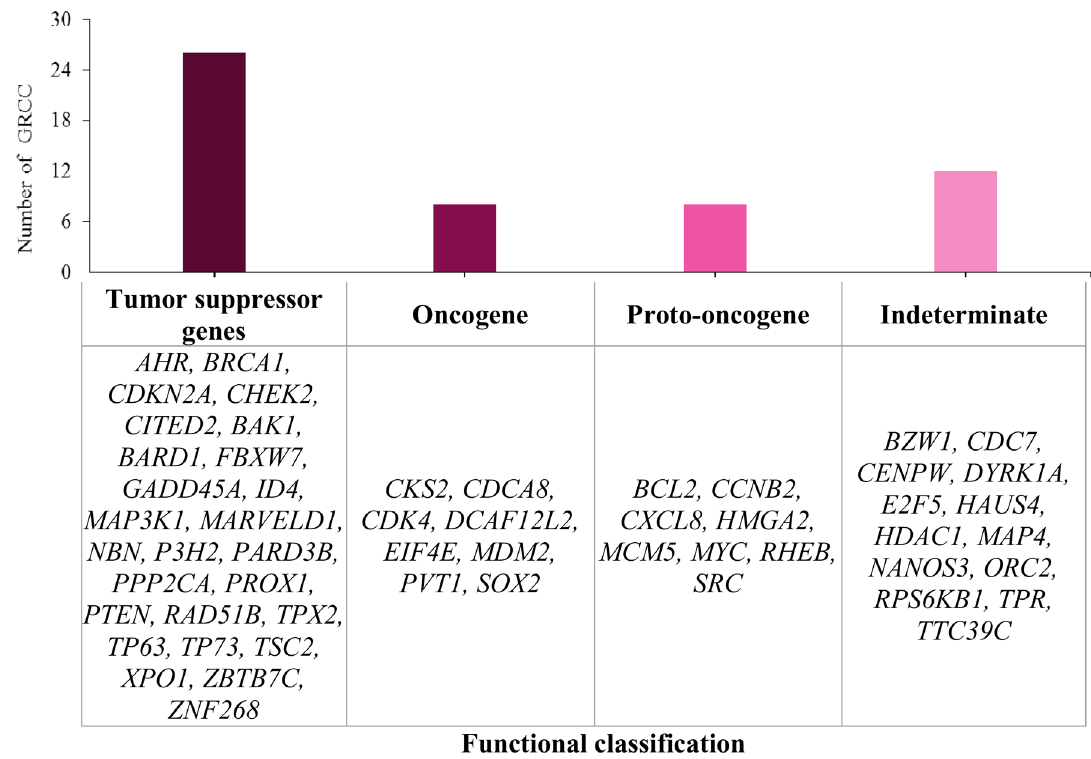
Figure 3. Functional classification of cellular genes in HPV integration sites (GRCC: cell cycle regulatory genes).